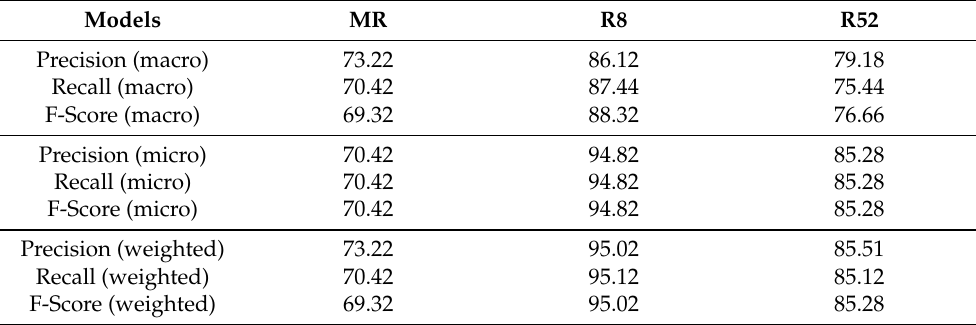
Table 4. Performance of TM for various evaluation metrics.